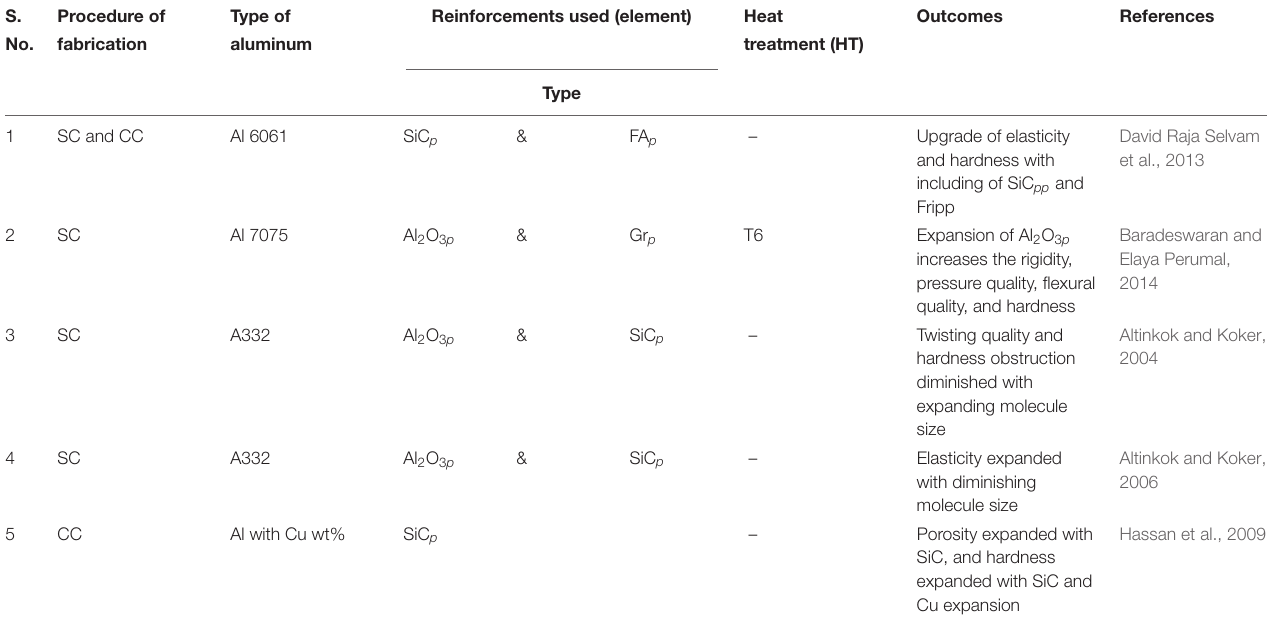
TABLE 2 | Mechanical characteristics comparison for different reinforcements for AMCs. S.